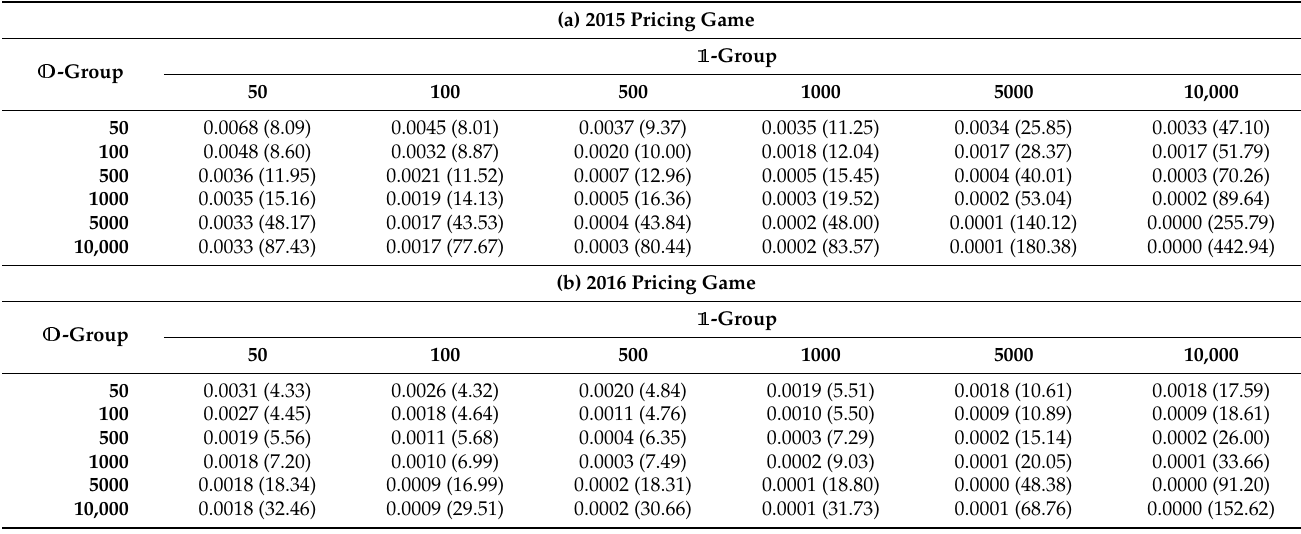
Table 5. Bias and run time (s), the latter between brackets, for the extended marginal approximation of C ≈ 2015 and 2016 pricing game dataset. This is given for the weighted-mean-plot approach and for several different numbers of boundary values for the O - and 1